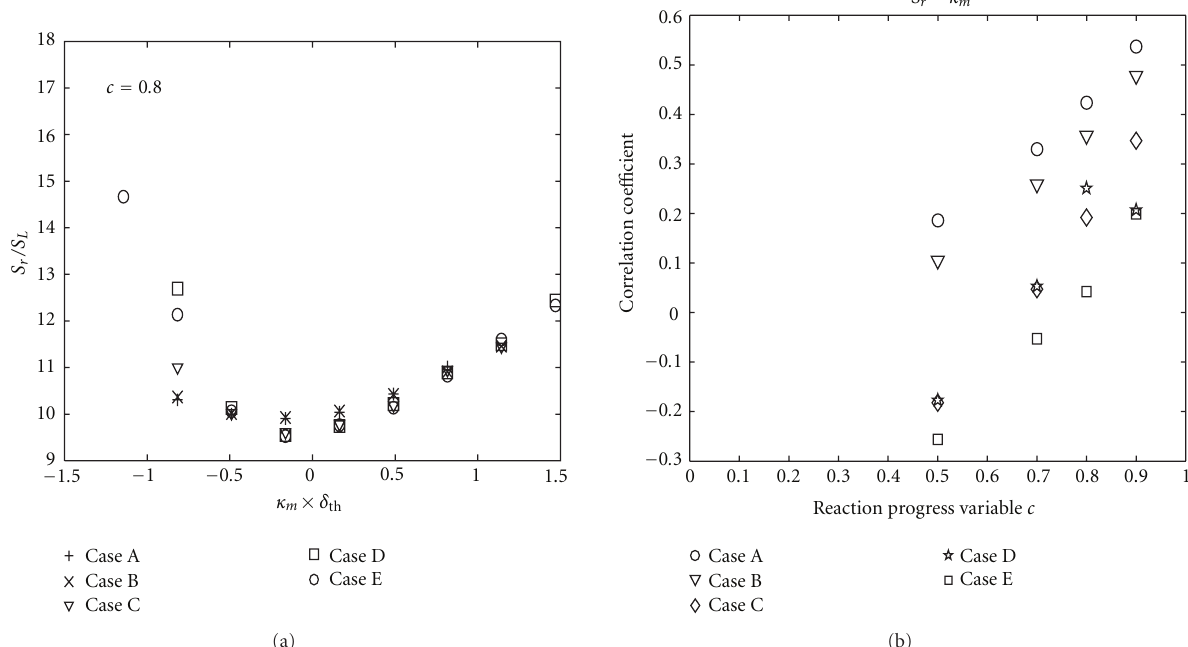
Figure 9: (a) Variation of mean values of S r /S L conditional on normalised curvature κ m × δ th for the isosurface at c = 0.8. (b) Variation of the correlation coe ffi cients between S r and κ m on the isosurfaces at c = 0.5 to 0.9 for all cases.